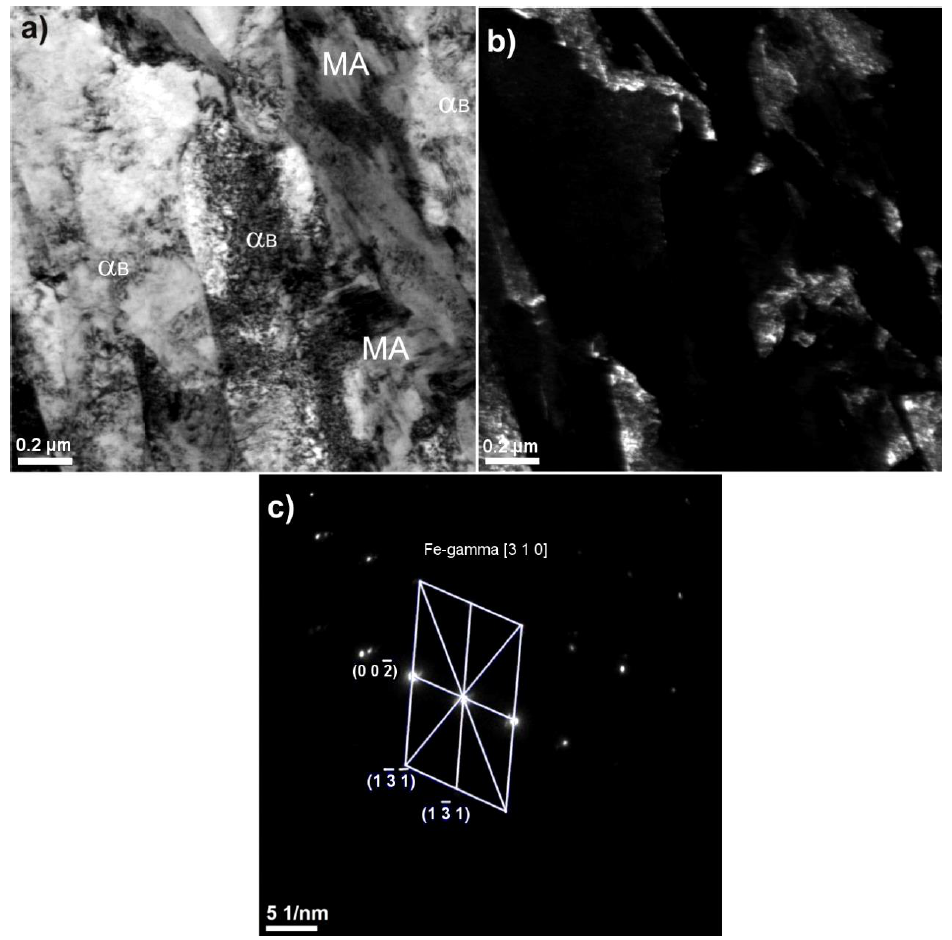
Figure 4. Austenite layers and blocky-type MA grains in bainitic ferrite in 3Mn-1.5Al steel ( a ) bright field, ( b ) dark field from (002) Fe γ , ( c ) SAD (Selection Area Diffraction) solution from the lower austenite lath; α B — bainitic ferrite, MA — martensite-austenite constituent.